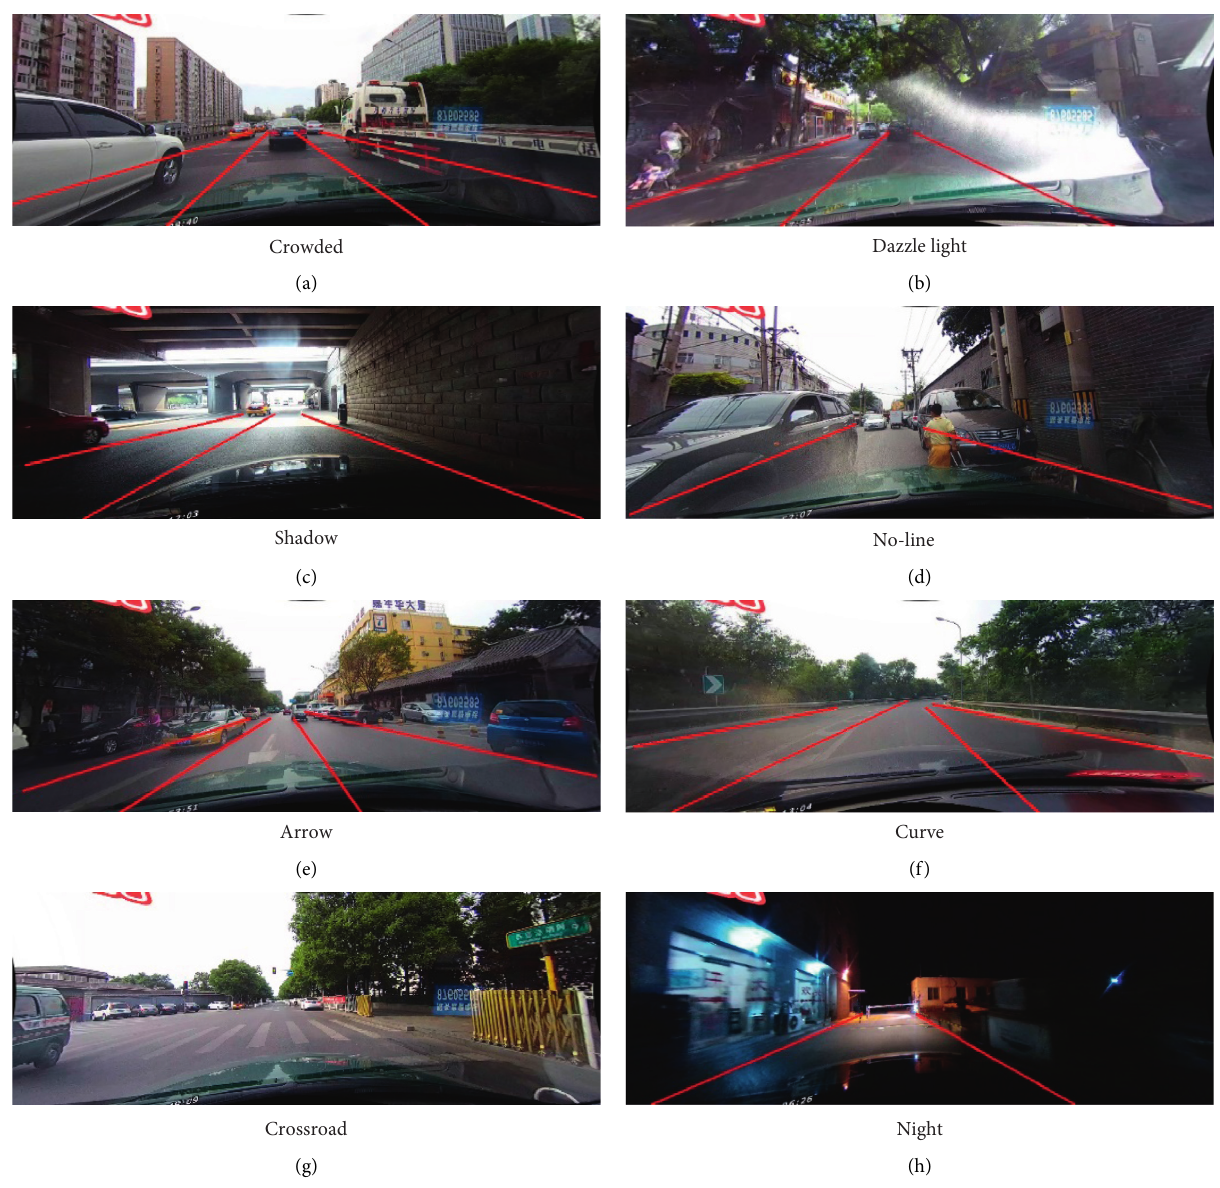
Figure 10: Testing on CULane. Since there is no line at crossroad, the detection result is none, as shown in (g). (a) Crowded. (b) Dazzle light. (c) Shadow. (d) No line. (e) Arrow. (f) Curve. (g) Crossroad. (h) Night. Table 5: The running time of algorithm (test on